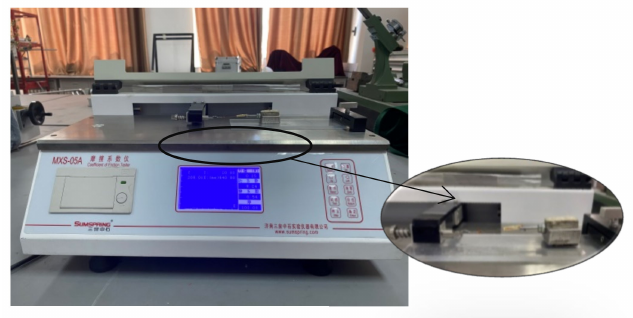
Figure 4. Static friction coefficient measurement